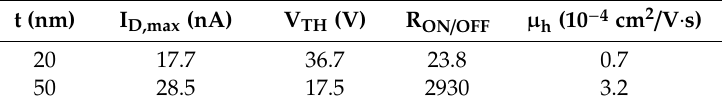
Table 1. Summary of parameters (dark condition) for the NIR-OPTRs with the CDS structures according to the thickness (t) of PMMA DLs. The data were extracted from the transfer curves in Figure 2b at V G = − 30 V, V D = − 30 V. I D,max and R ON / OFF denote the maximum drain current (V G = − 30 V, V D = − 30 V) and on / o ff ratio, respectively. t (nm) I D,max